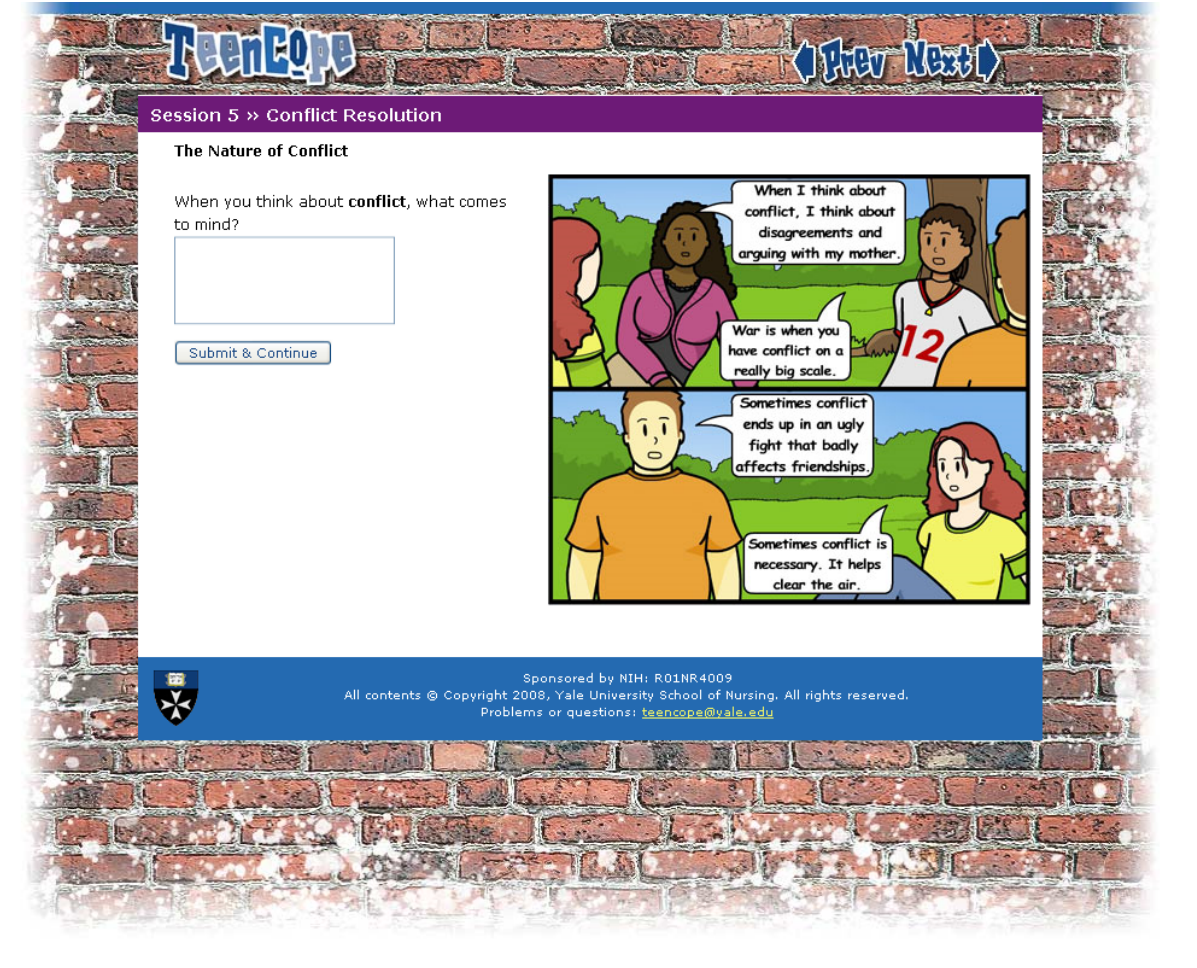
Figure 2. TEENCOPE screenshot displaying graphic novel format for conflict resolution